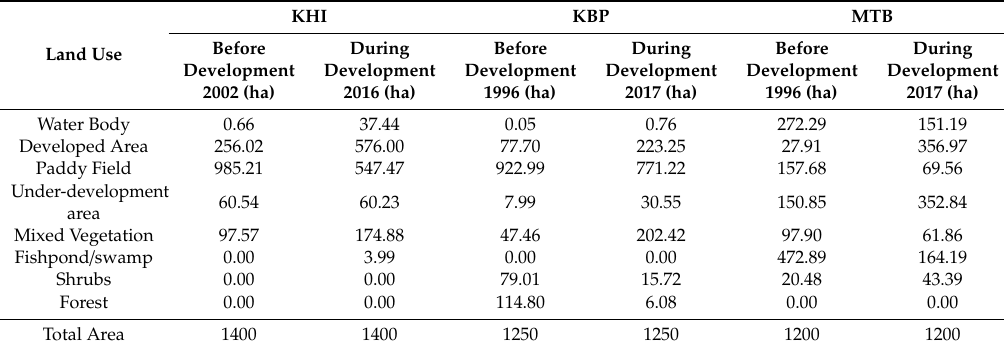
Table 2. Spatial transformation in KHI, KBP, and